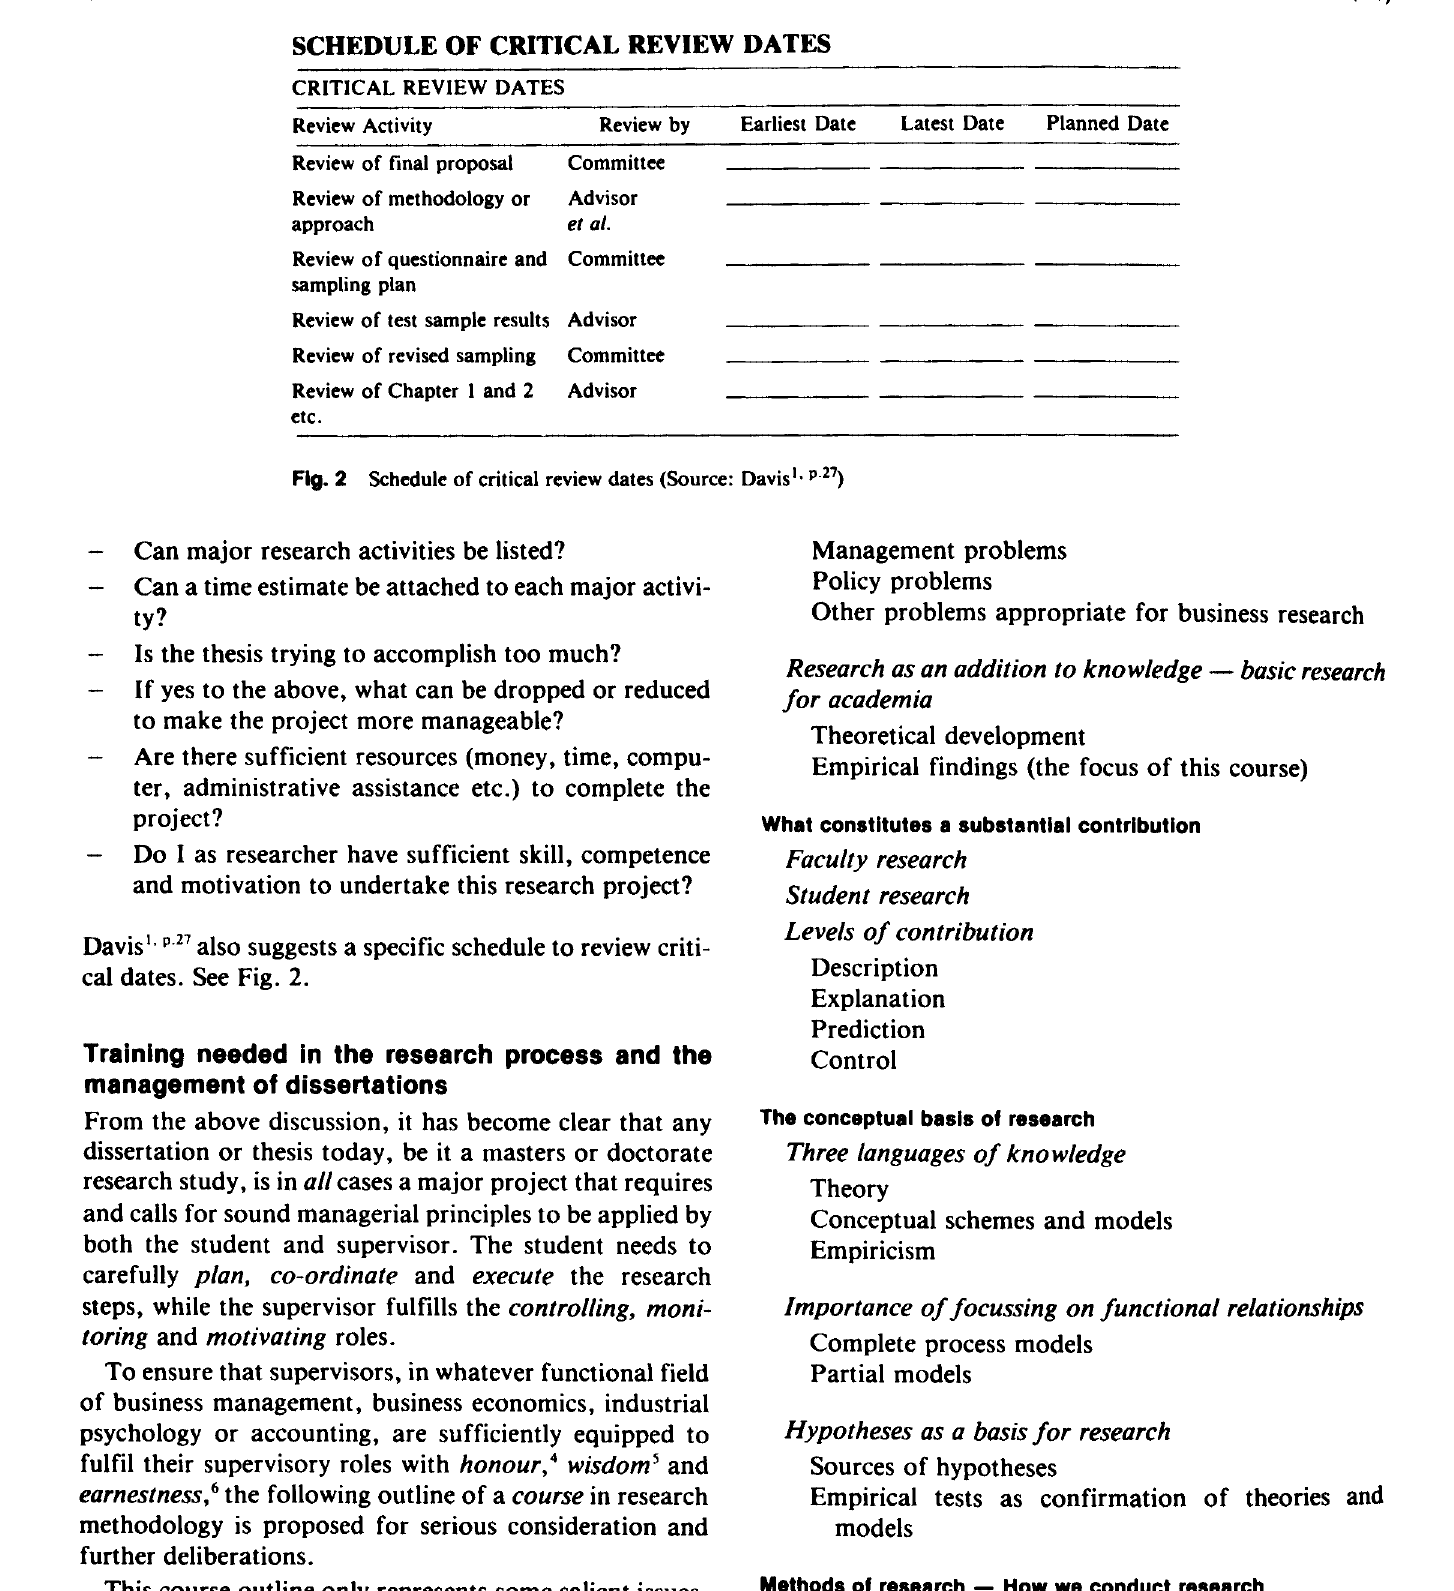
Fig. 2 Schedule of critical review dates (Source: Davis 1 •